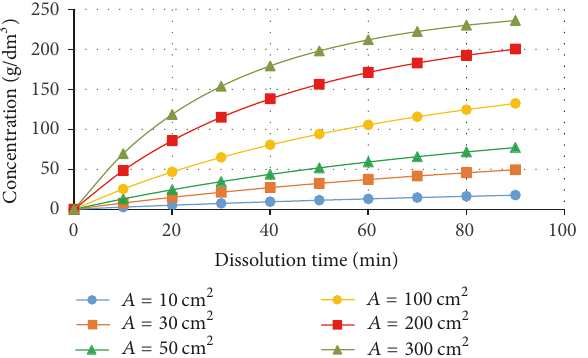
Figure 9: Change of the concentration of rock salt with dissolution time for different dissolution areas ( 𝐴 ).